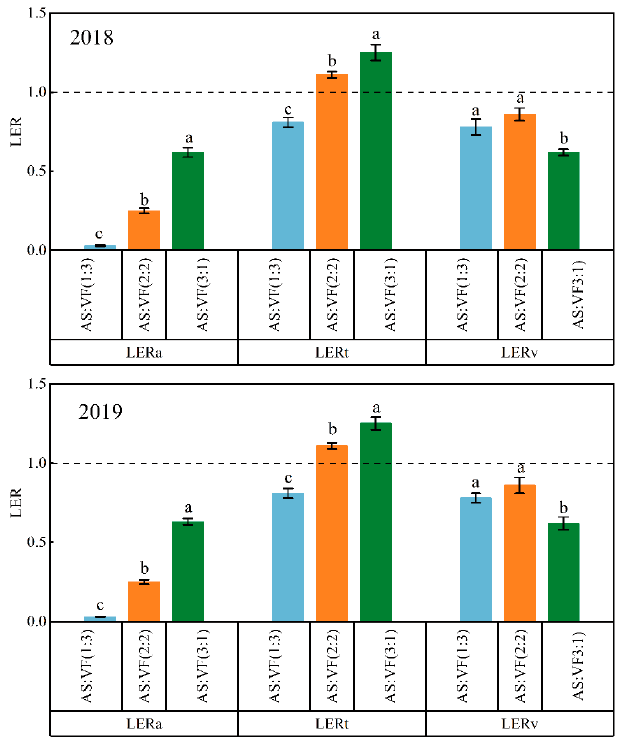
The value of LER was greater than one in the AS/VF (3:1) and AS/VF (2:2) intercrop- ping patterns (Figure 2) both in 2018 and in 2019. The highest LER values (1.24 and 1.25) were obtained in the AS/VF (3:1) intercropping pattern in 2018 and in 2019. The partial LER of A. sinensis decreased as the proportion of A. sinensis decreased in the intercropping patterns, while the partial LER of V. faba increased first and then decreased as the proportion of A. sinensis increased in the intercropping patterns.